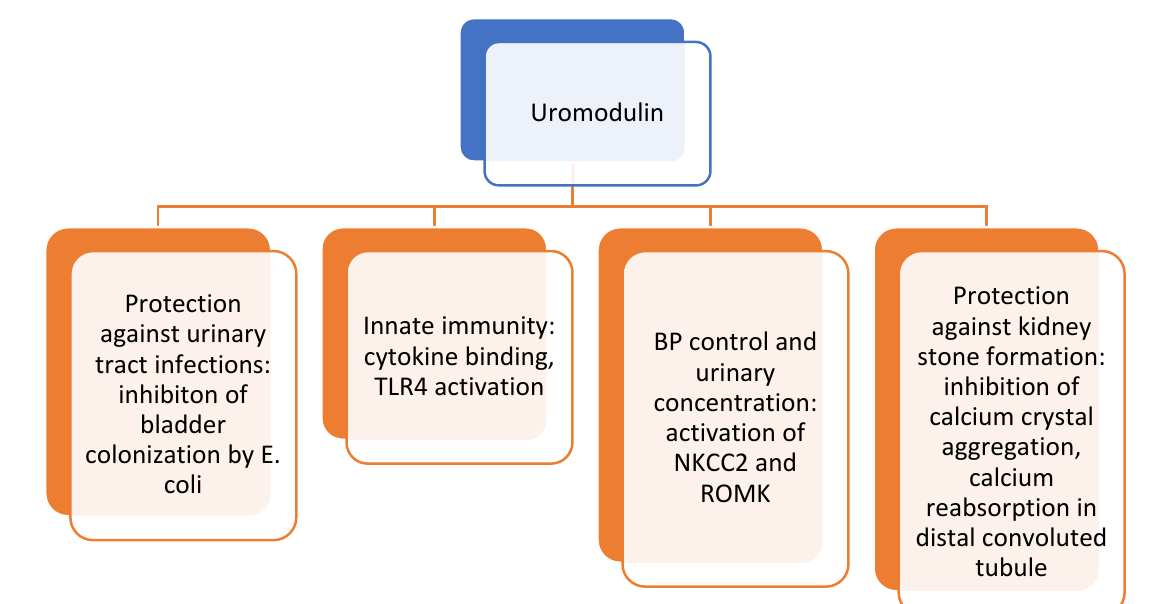
Figure 3. Proposed physiological roles of uromodulin. TLR4—Toll-like receptor 4; NKCC2—Na+-K+-2Cl-cotransporter; ROMK—potassium channel ROMK, BP—blood pressure. Uromodulin is negatively charged in the urine, which inhibits crystal aggregation.